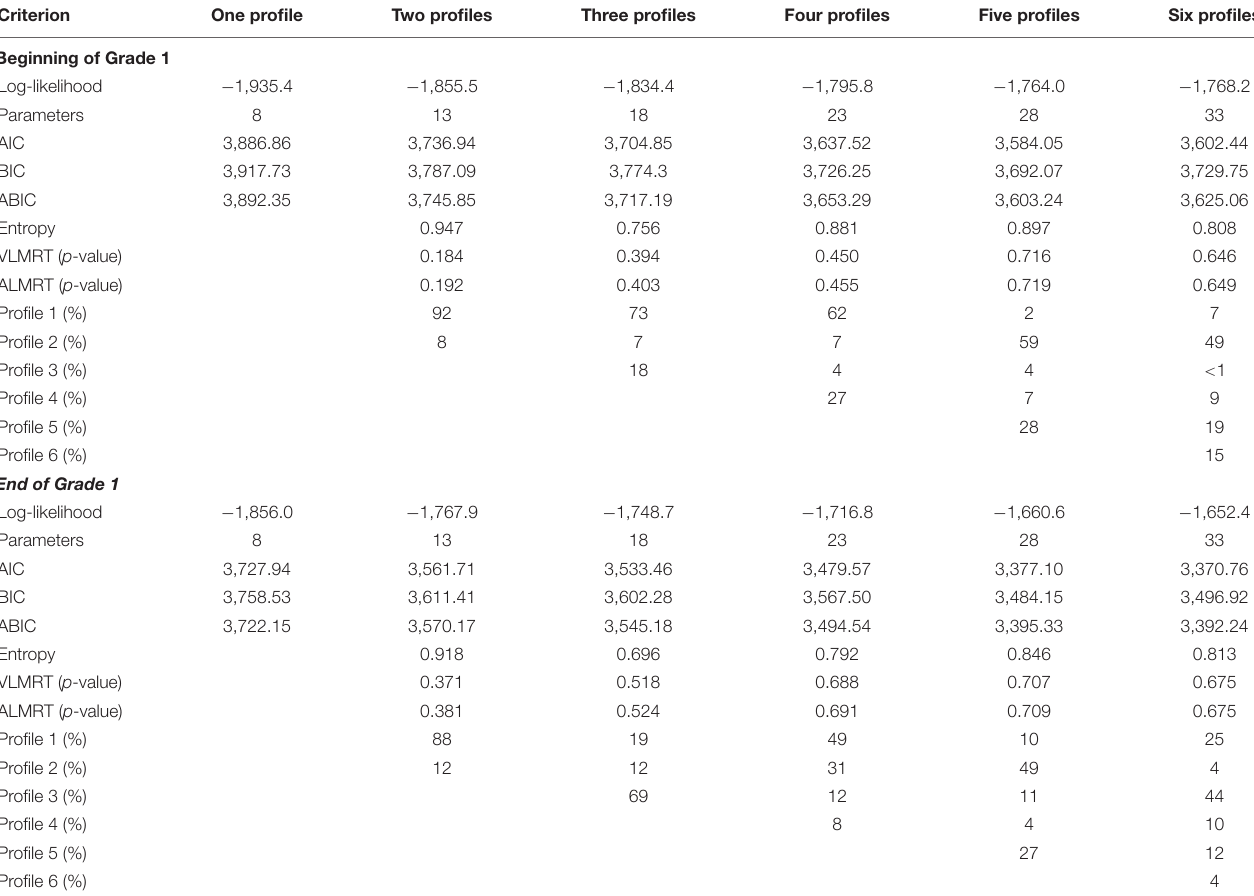
TABLE 3 | Fit indices for latent profile analysis for 1–6 latent profiles at the beginning (T1) and end (T2) of Grade